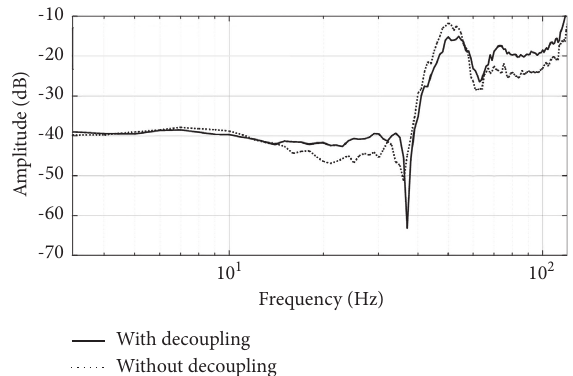
Figure 11: Comparison of random signal before and after decoupling with eccentric load. (a) Acceleration and (b) frequency domain